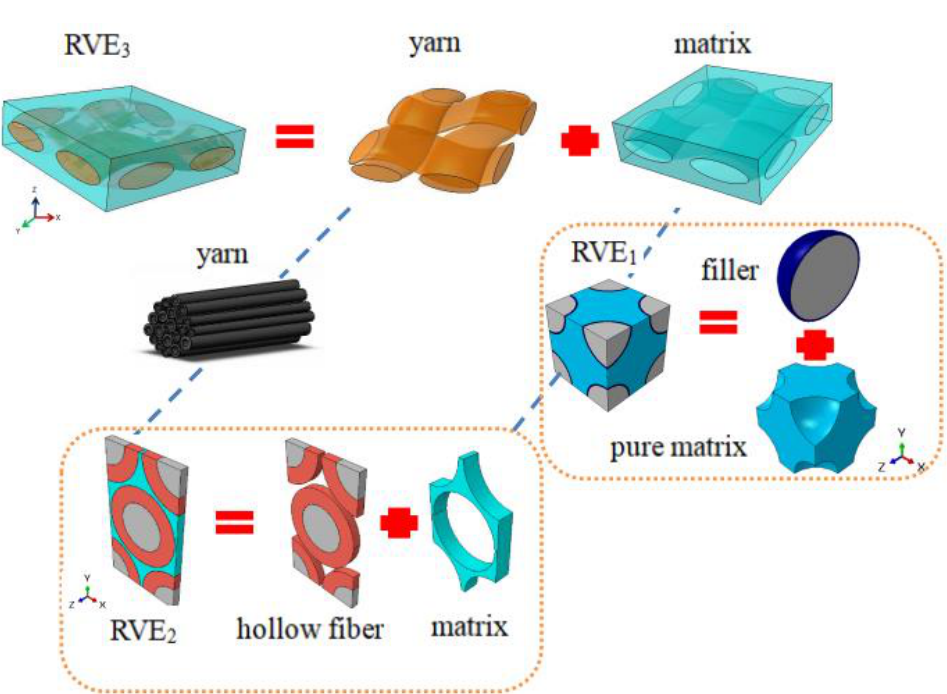
Figure 1. Progressive modeling framework of woven composites with HGBs and HFs.